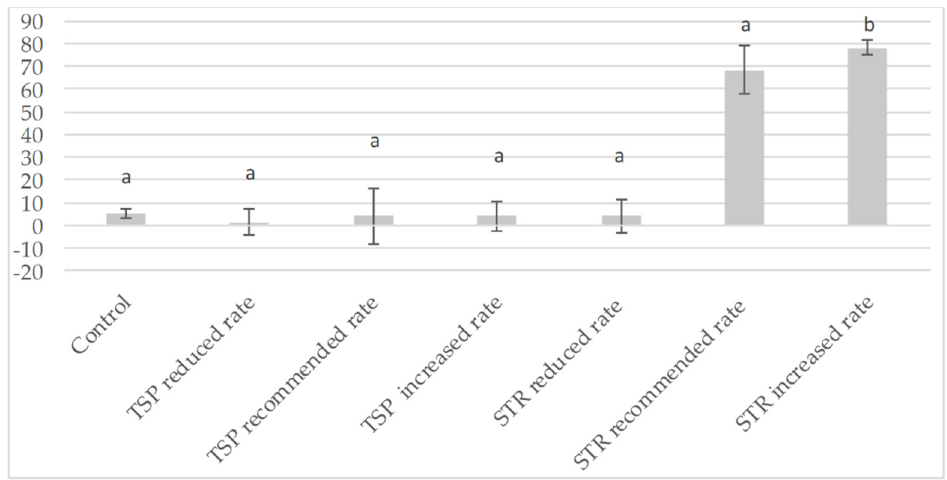
Figure 9. Nitrate nitrogen content in the peat (mg dm − 3 ) as affected by the interaction of examined factors (A × B) at the level of significance α = 0.05 ( p value < 0.001).